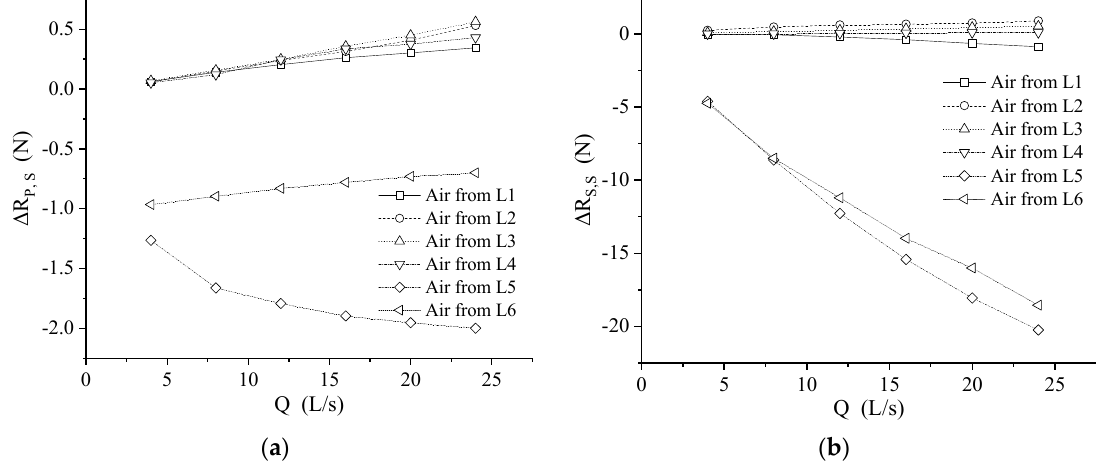
Figure 16. Changes in the resistance component of the strut: ( a ) Component related to the pressure force; ( b ) Component related to the shear force.